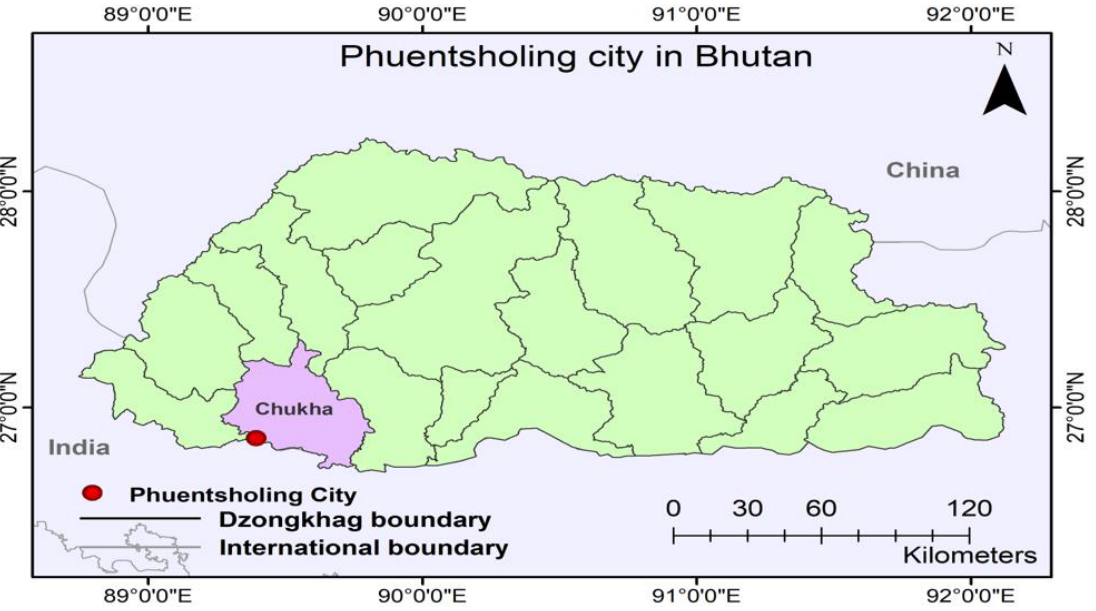
Figure 3. Map of Phuentsholing City in Bhutan (Authors, 2022).